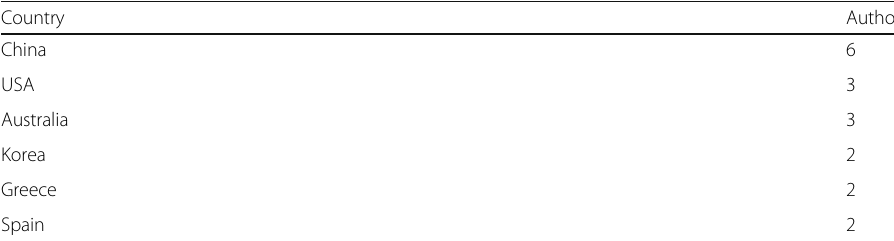
Table 3 List of country of origin of authors